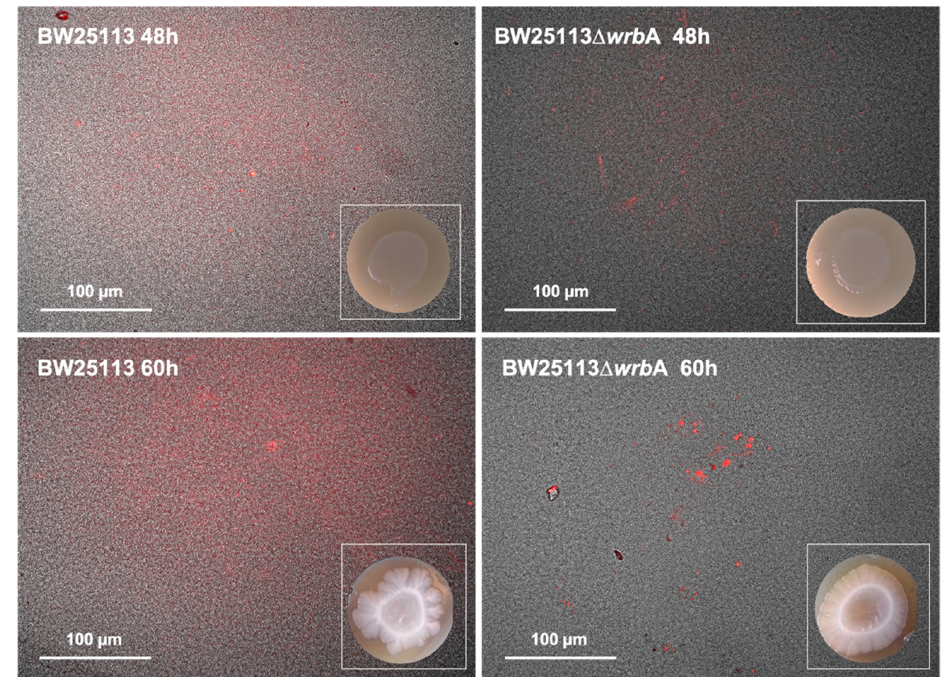
Figure 3. Biofilm morphology and visualization of extracellular curli in BW25113 and BW25113- ∆ wrb A biofilms after 48 and 60 h. Pictured were obtained by merging bright field and fluorescence images of biofilms grown on CR agar medium. Representative images are shown.